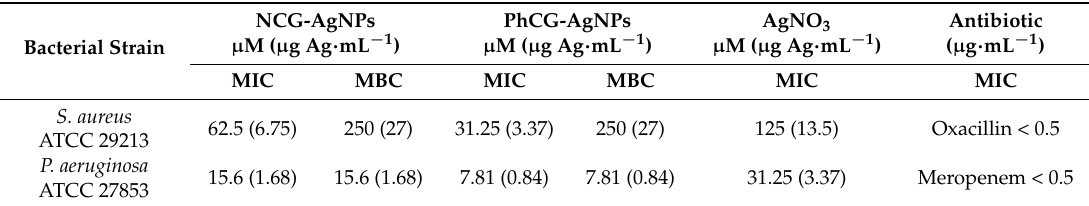
Table 1. Minimum inhibitory concentrations (MIC) and minimum bactericidal concentrations (MBC) of NCG-AgNPs and PhCG-AgNPs